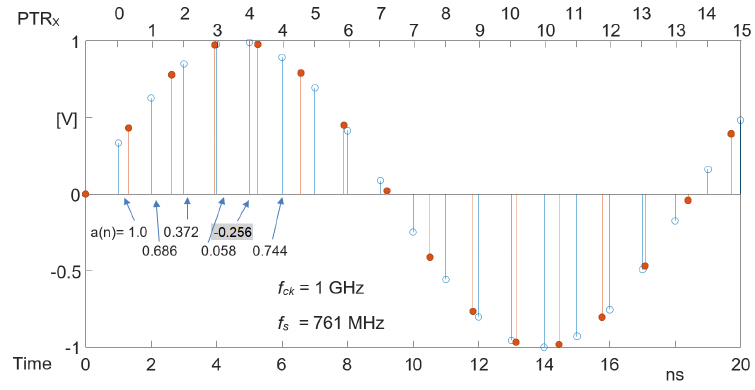
Figure 6. Example sequences for a ( n ) and Ptr X